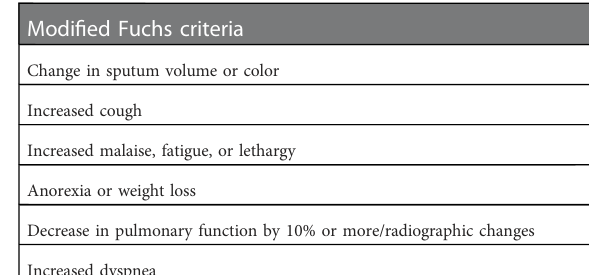
TABLE 2 Modi fi ed Fuchs criteria according to the European Consensus Group: at least 2 out of 6 of the following signs and symptoms must be present for respiratory tract exacerbation